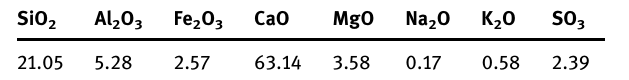
Figure 1: Image of